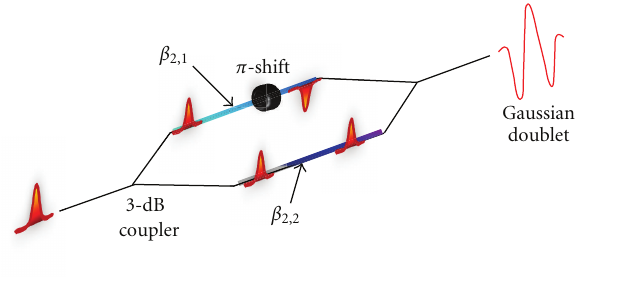
Figure 2: Possible doublet pulse generation scheme.